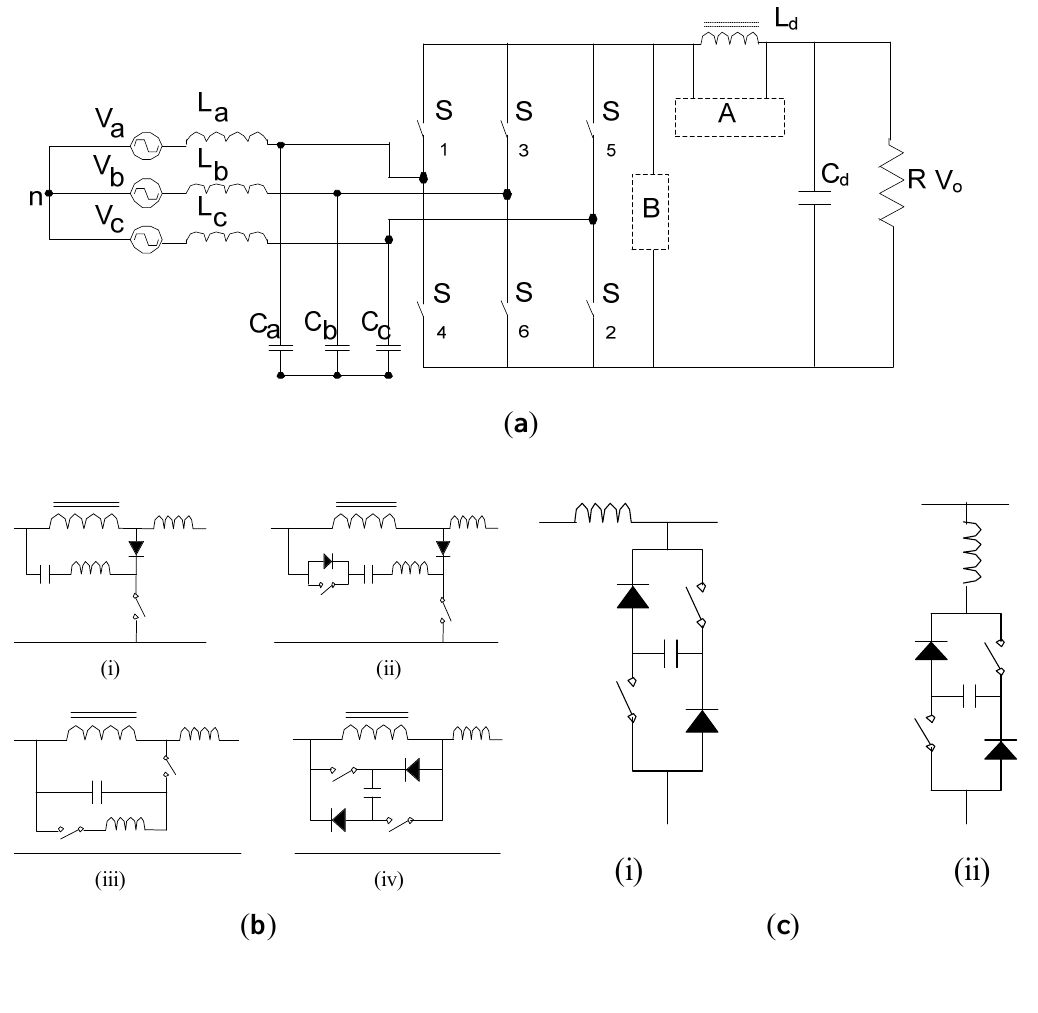
Figure 5. ( a ) Three-phase six-switch rectifier. ( b ) Various auxiliary circuit schemes for position A. ( c ) Various auxiliary circuit schemes for position